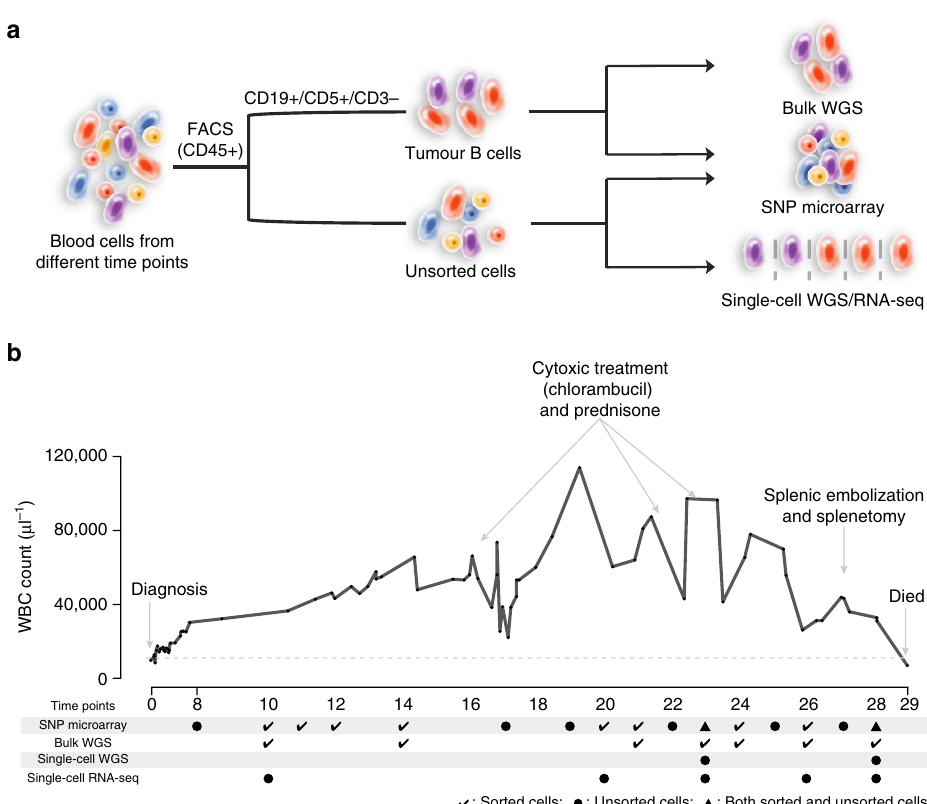
Figure 1 | Sample and clinical information. ( a ) Schema of the sample isolation and the sequencing strategy. FACS, fluorescence-activated cell sorting. WGS, whole-genome sequencing. RNA-seq, RNA sequencing. ( b ) Clinical information and corresponding samples analysed. Top, white blood cell counts (WBC) from diagnosis to year 29 following diagnosis. The dashed grey line indicates the normal upper level of WBC. Additional clinical information is shown in Supplementary Fig. 1. Bottom, the matched sequencing